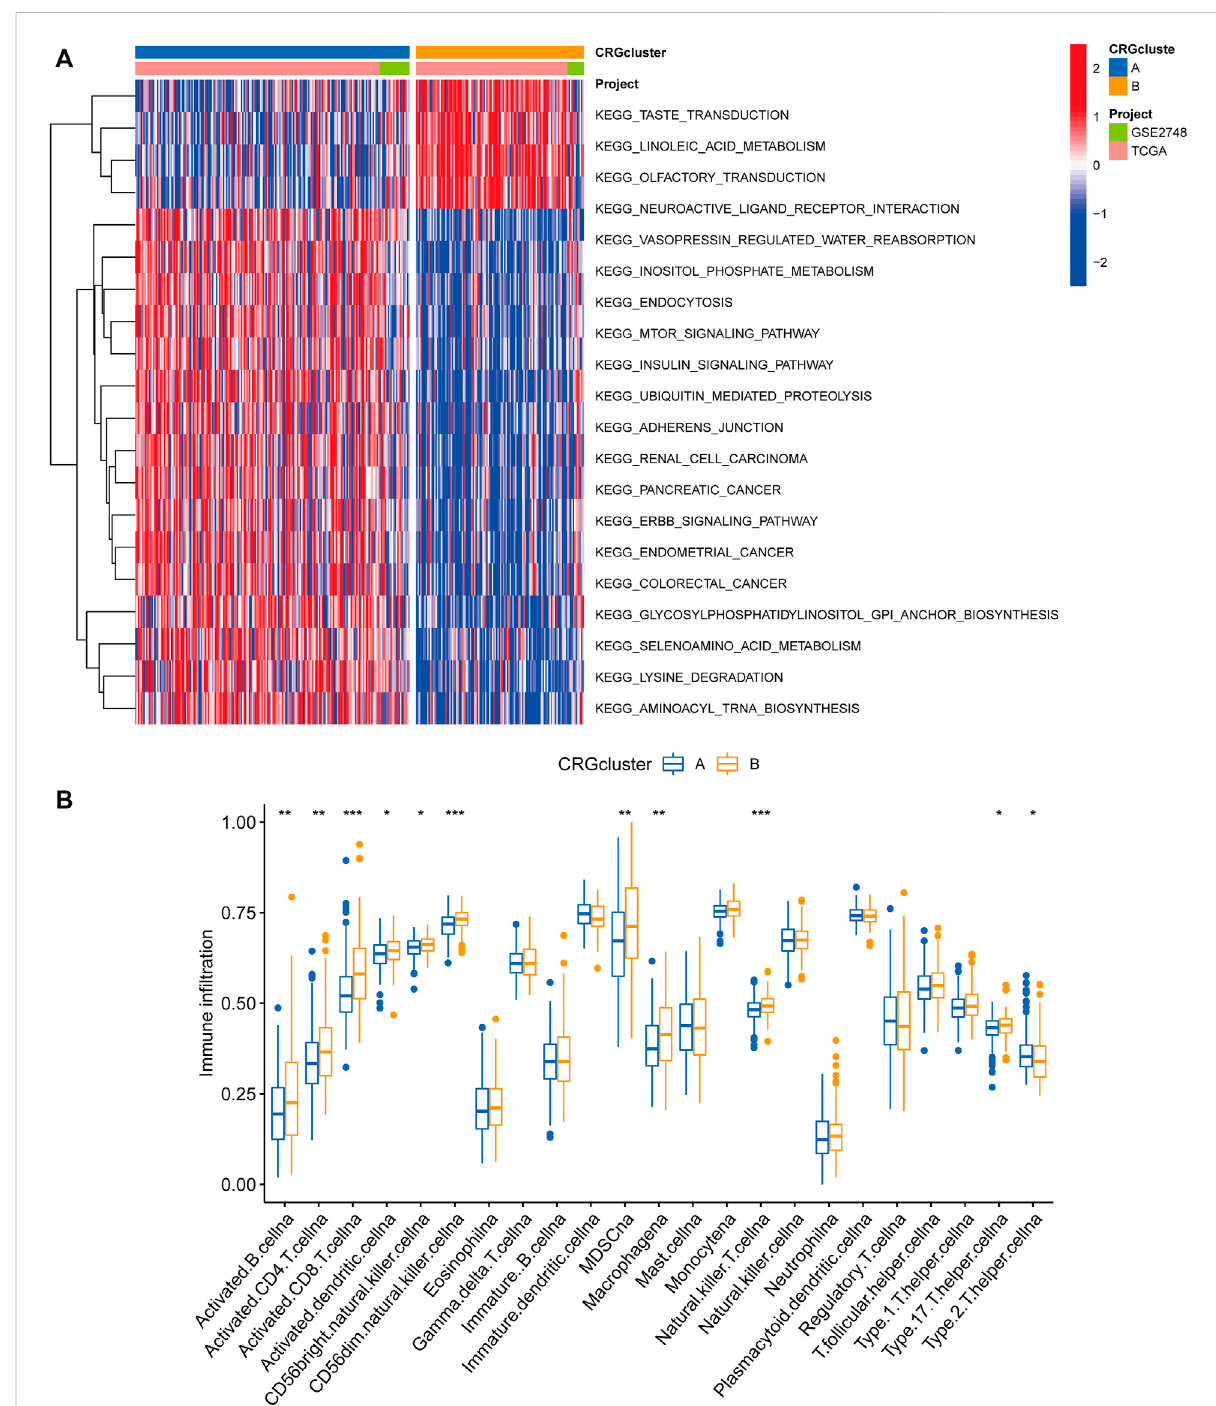
FIGURE 3 Correlations between the microenvironment of tumor immune cells and two PRCC subclusters. (A) Gene set variation analysis (GSVA) of biological pathways divided intotwo separate subclusters,withred denotingactive pathwaysand bluedenoting inhibited pathways, respectively. (B) The degrees of tumor microenvironment immune cell in fi ltration between the two CRG clusters. Blue symbolizes cluster A, whereas orange representsclusterB.The medianvalueisindicatedbythethickline,andtheinterquartilerange bythebottomand topofthebox.Thedispersed dots signify anomalies. (* p < 0.05; ** p < 0.01; *** p <